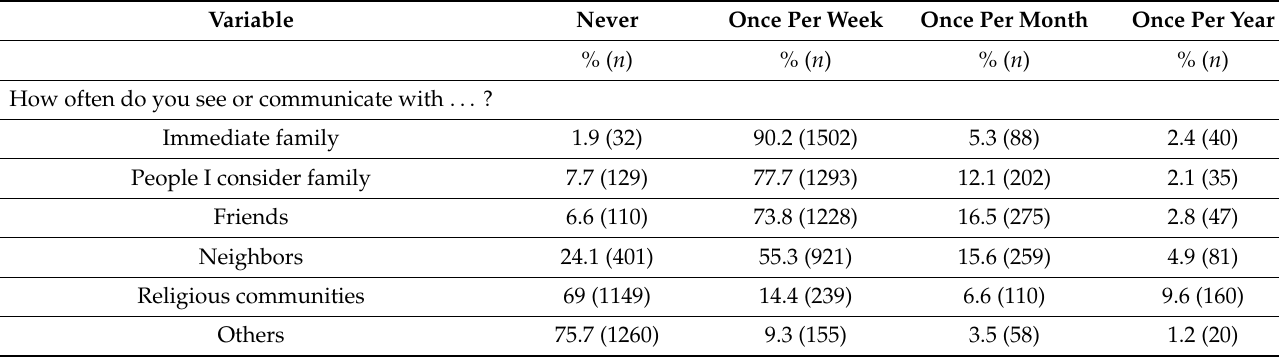
Table 2. Descriptive statistics of structural social capital.